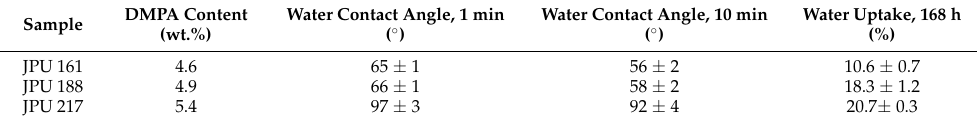
Table 5. Water contact angle and water uptake of the JPU films.